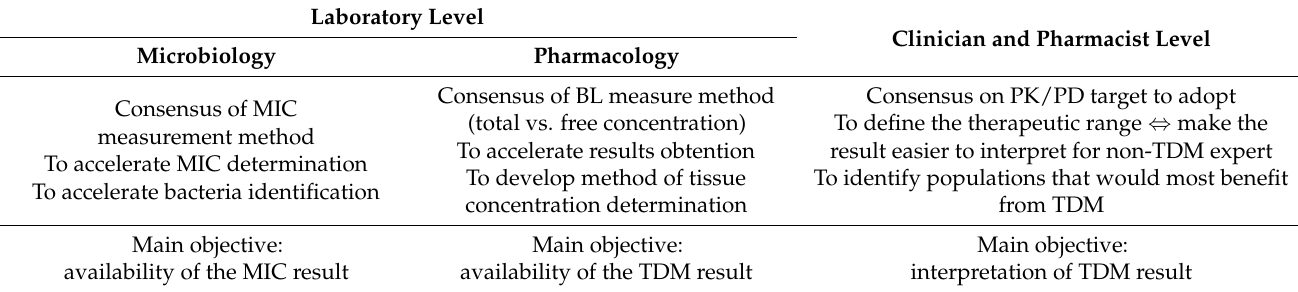
Table 1. Barriers to counter for a better TDM